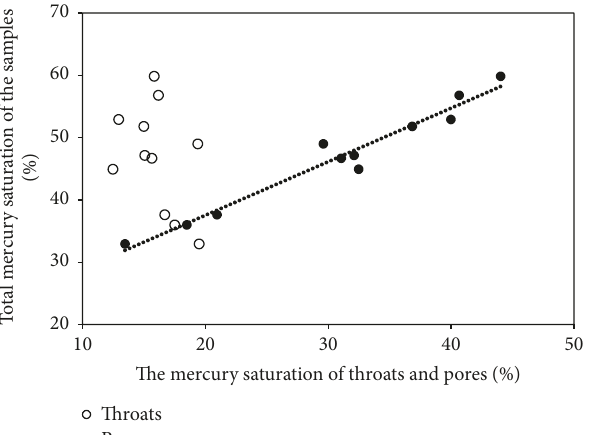
Figure 11: The correlation of total mercury saturation and the portion from throats and pores, implying the portion of valid porosity that result from throats and pores